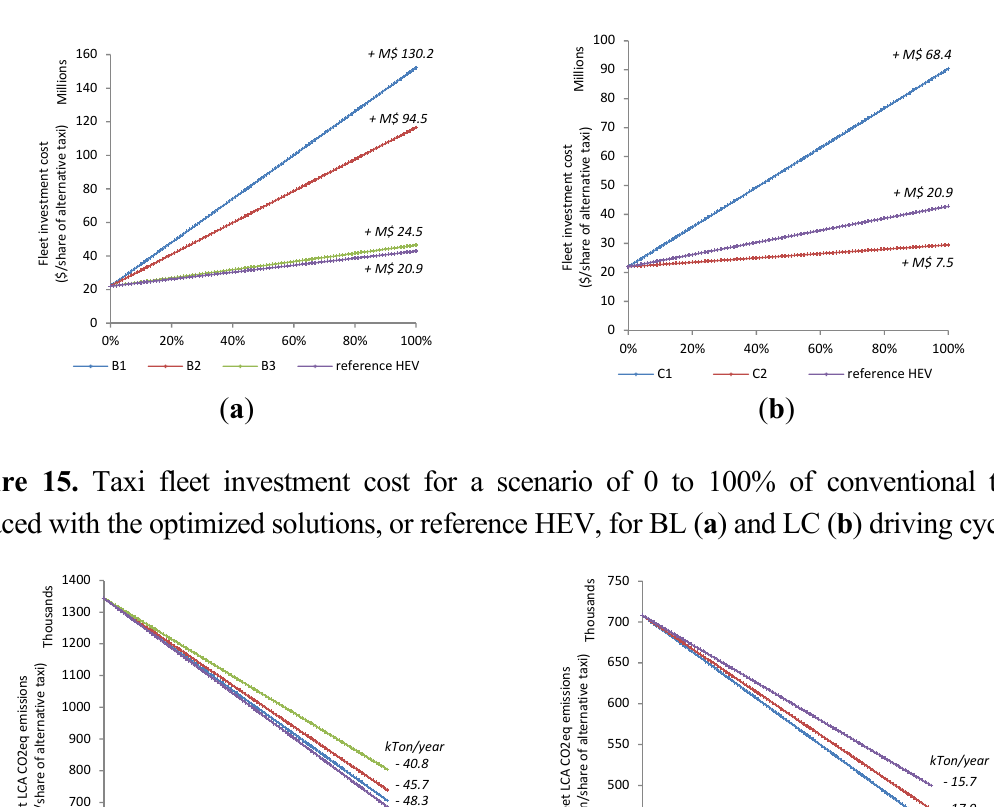
Figure 14. Taxi fleet financial gain for a scenario of 0 to 100% of conventional taxis replaced with the optimized solutions, or reference HEV, for BL ( a ) and LC ( b ) driving cycles.